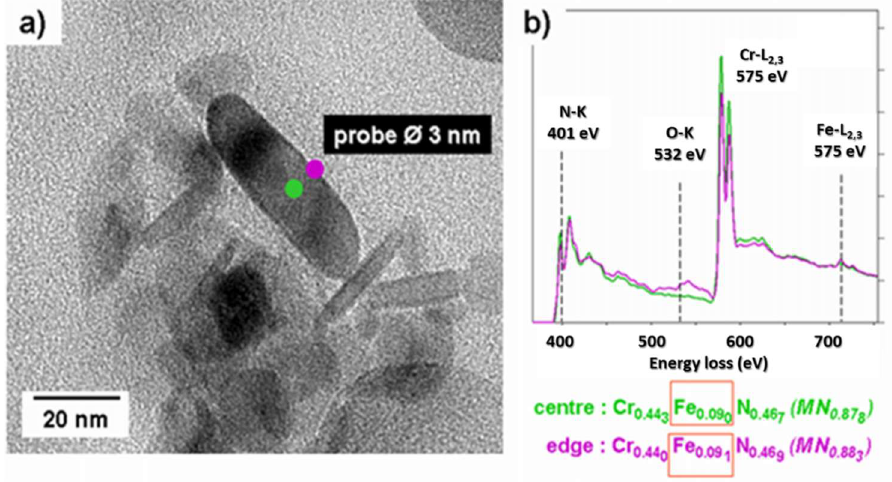
Figure 9. EELS spectra ( b ) of a nitride lying on a carbon replica (a ) and corresponding Cr and Fe contents. (The Fe-concentration does not differ significantly between the core of the nitride and its